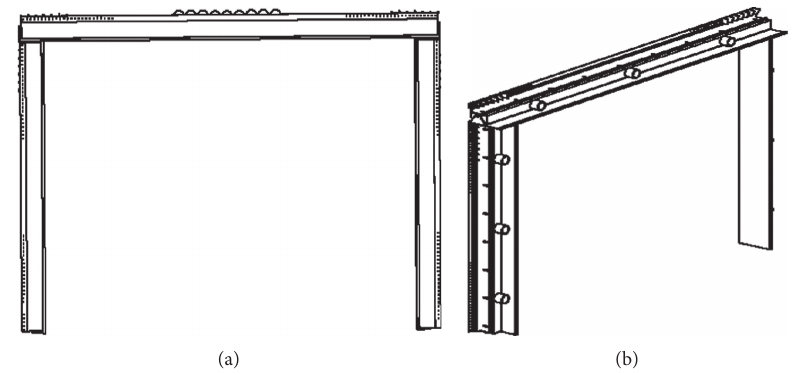
Figure 4: Overall appearance structure of an air curtain injection device.